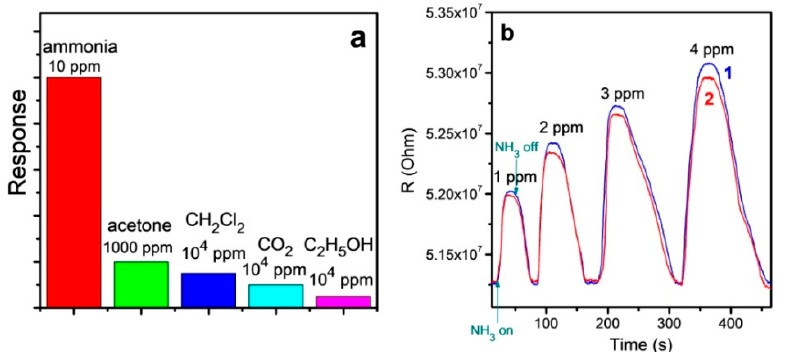
Figure 6. ( a ) Response of a ZnPcF 4 film to ammonia (10 ppm), acetone (1000 ppm), dichloromethane (104 ppm), carbon dioxide (104 ppm), ethanol (104 ppm). ( b ) Sensor response of a ZnPcF 4 layer toward ammonia in the concentration range from 1 to 4 ppm, in air (1) and in a mixture of gases with the composition close to exhaled air of healthy people (N 2 , 76%; O 2 , 16%; H 2 O, 5%; and CO 2 , 3%) (2) [21].